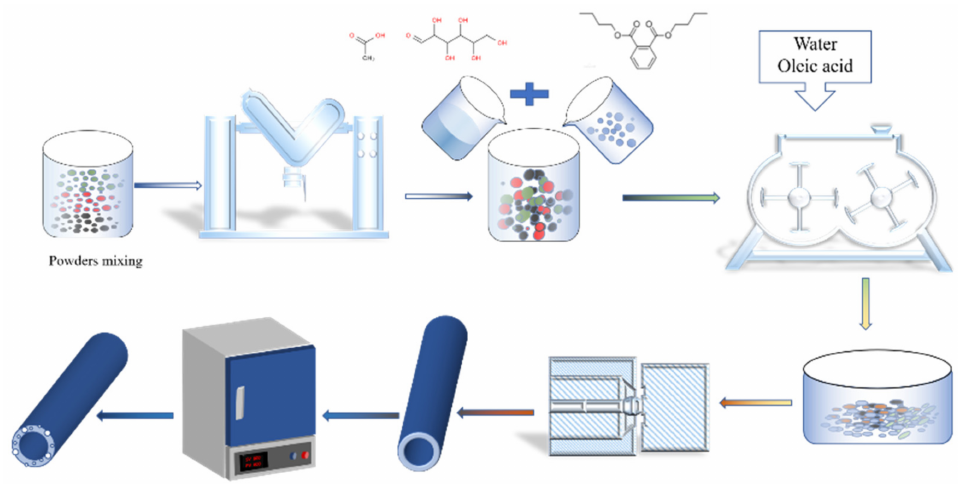
Figure 1. Schematic diagram illustrating the preparation process of single-channel Al 2 O 3 -based